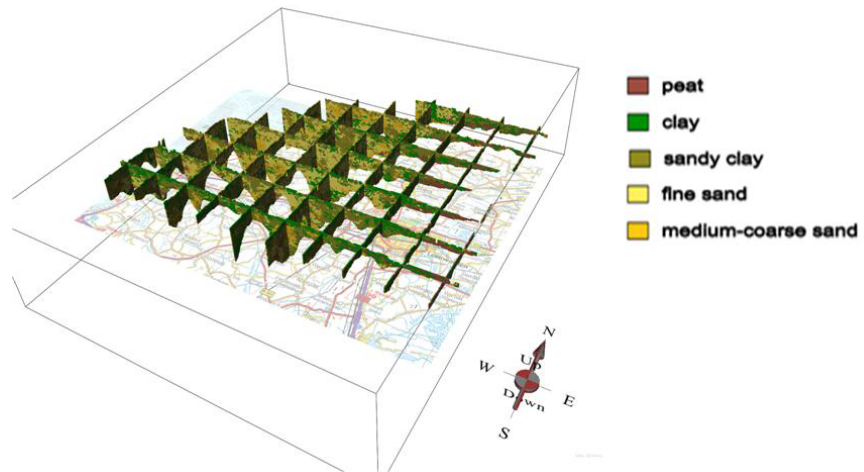
Figure 7 3-D view (left) and top view (right) showing the model boundaries.